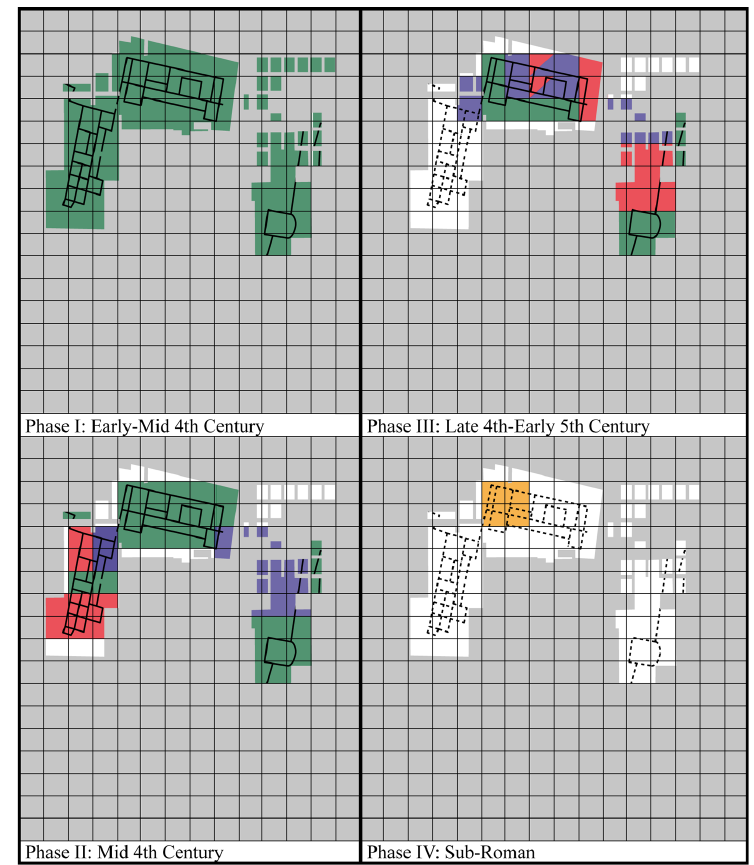
Figure 4: A low-resolution view of transformation at Beadlam, highlighting different types of transformational activity laid out in Table